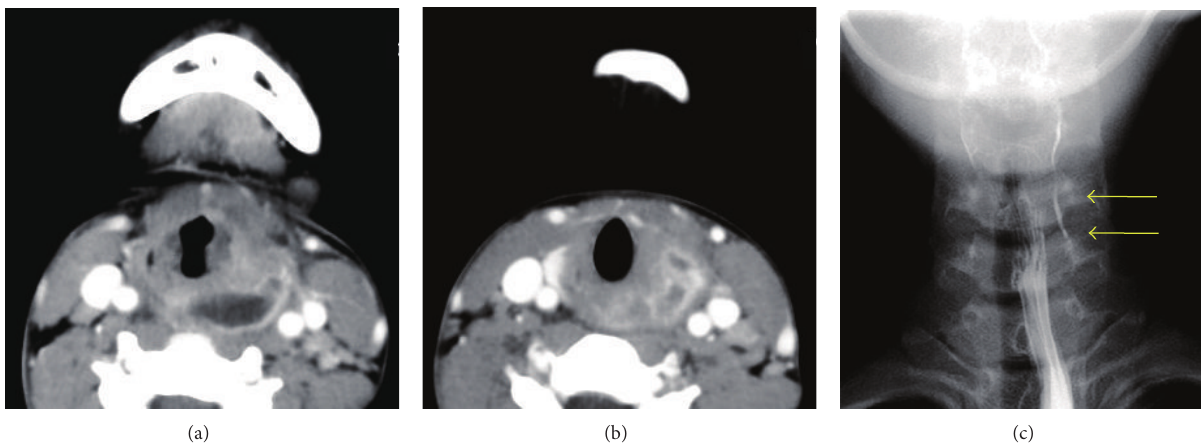
Figure 1: (a) A computed tomographic scan showing a deep neck infection that was located between the common carotid artery and hypopharynx. (b) The infection reached the thyroid beyond the capsule and occurred with acute suppurative thyroiditis. (c) Barium swallow examination shows obvious leakage of barium from the left pyriform sinus, which indicated the presence of a fistula (arrows). Only one fistula was identified in this